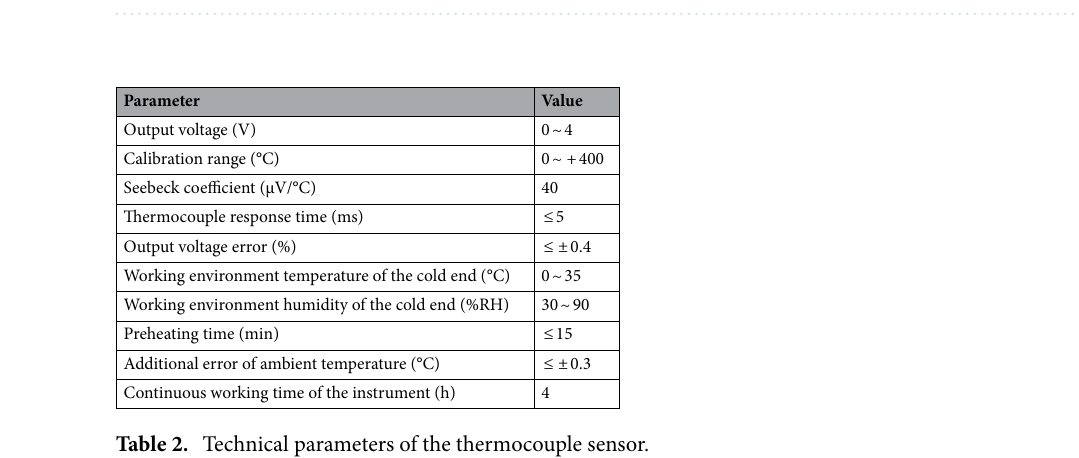
Table 1. Main parameters of the engine.